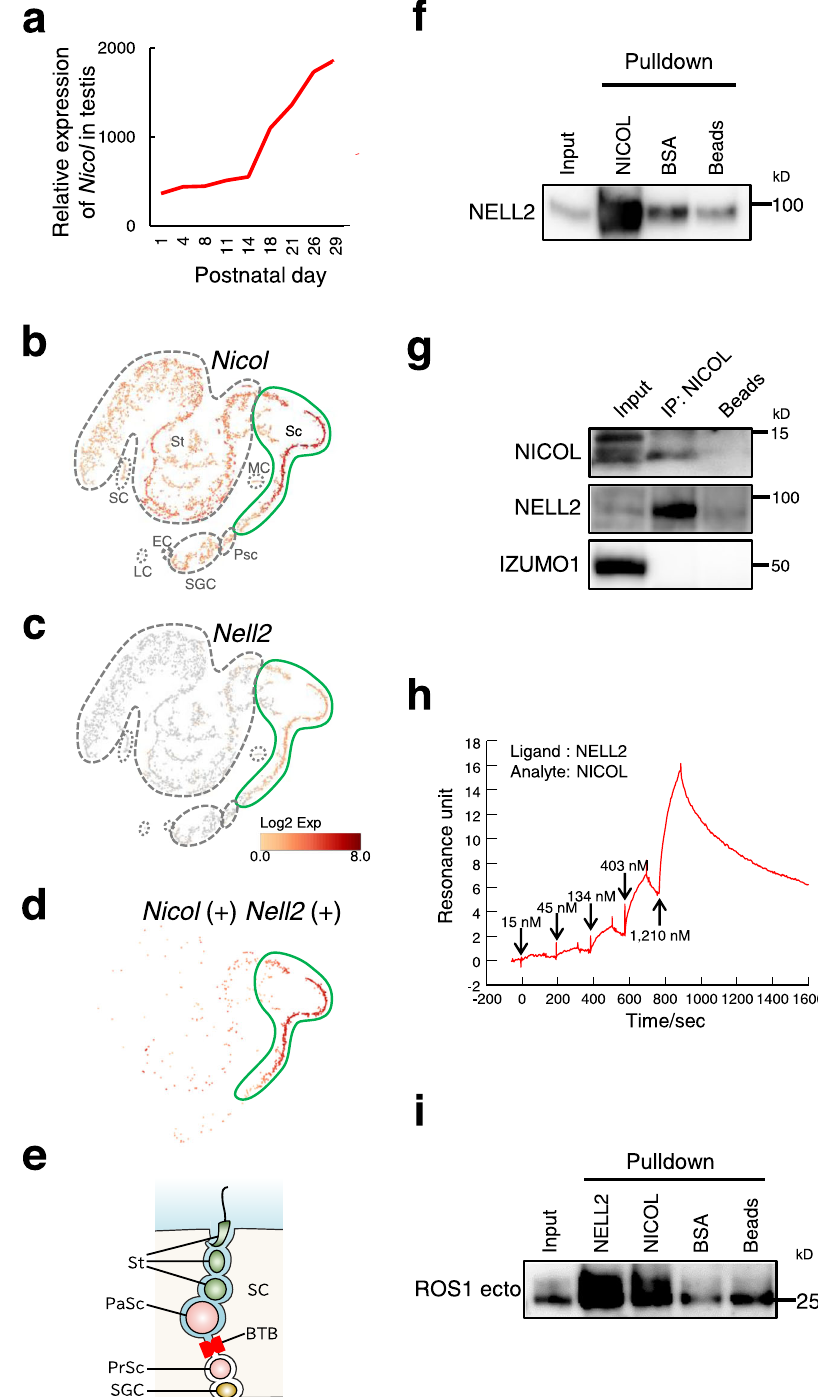
Fig. 5 | NICOL forms a complex with NELL2. a RNA expression pro fi le of Nicol in developingtestis. b – d t -distributedstochasticneighbourembeddingplotsofadult mouse testis single-cell RNA-seq data representing Nicol ( b ) and Nell2 ( c ) expres- sion. Nicol expression in Nell2 -expressing cells is also shown ( d ). Nicol is broadly expressed with highest expression in leptotene, pachytene, and diplotene sper- matocyte populations, which also show the highest Nell2 expression. SGC sper- matogonial stem cells, P Preleptotene spermatocytes, LZPD leptotene, zygotene, pachytene, and diplotene spermatocytes, St spermatids, SC Sertoli cells, EC endothelialcells,MCmyoidcells,LClymphaticcells. e Schematicrepresentationof seminiferous tubule histology. SGC spermatogonial stem cell, PrSc preleptotene spermatocyte, PaSc pachytene spermatocyte, St spermatid, SC Sertoli cell, BTB